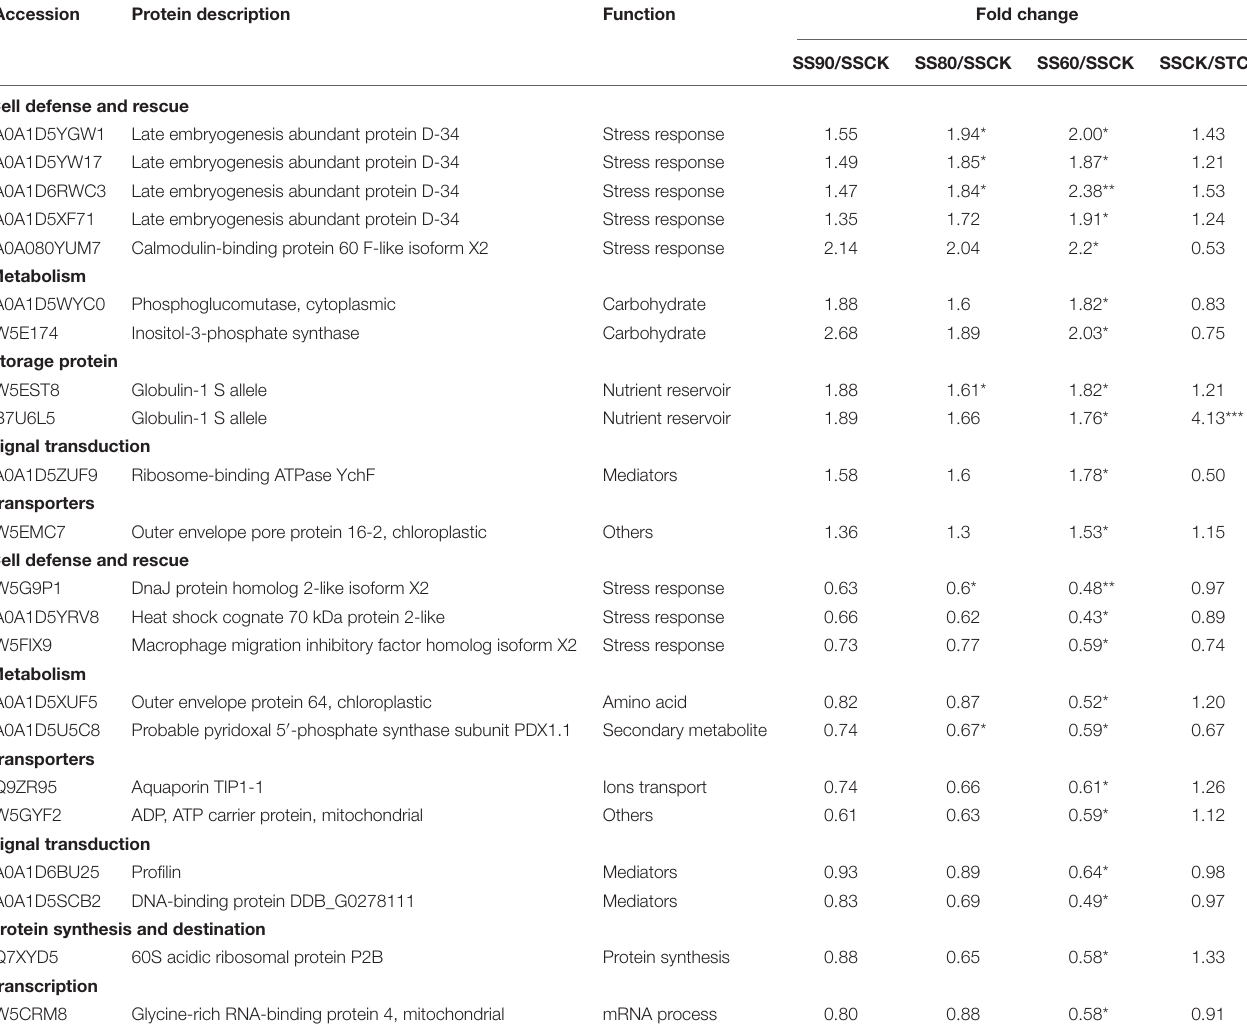
TABLE 4 | List of SS- specific differentially abundant proteins with significant trend in up- and down-regulation during artificial aging at 40 ◦ C and 75% relative humidity. Protein